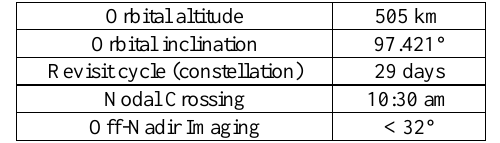
Table 1. The specifications of the satellite